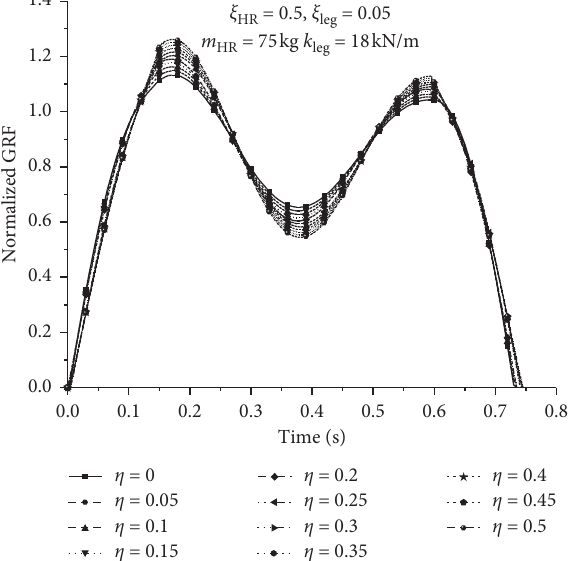
Figure 35: Normalized GRF under different stiffness